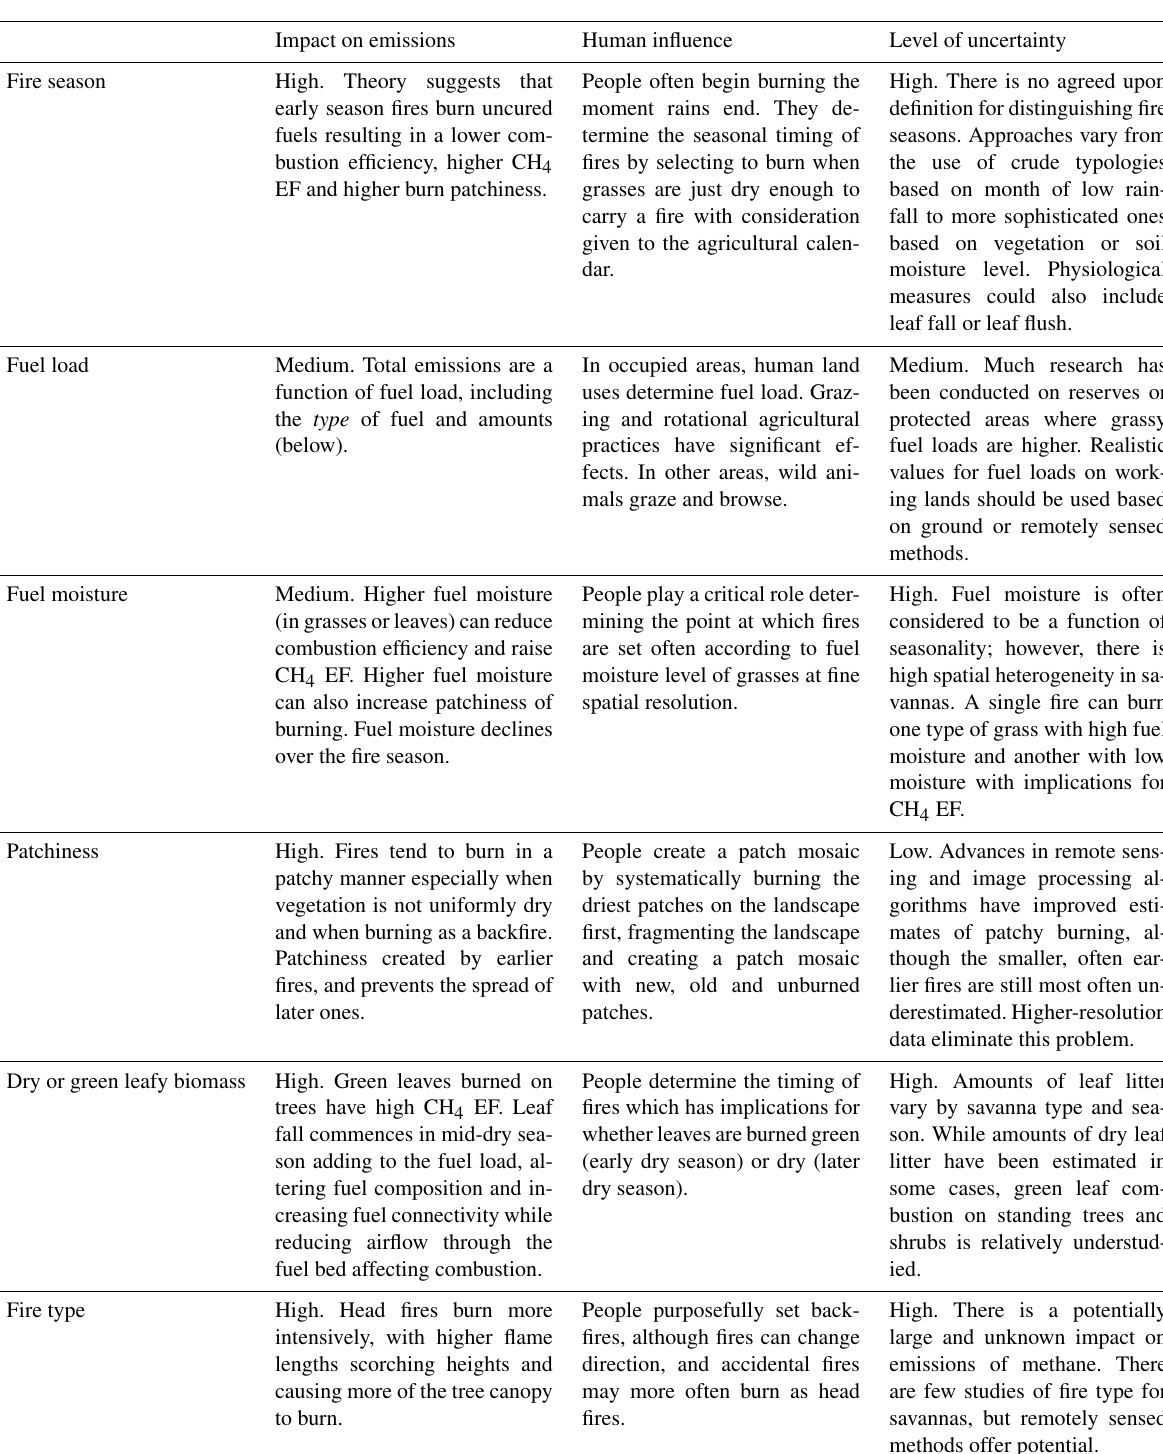
Table A1. Factors affecting methane emissions from West African savanna fires, human influence and